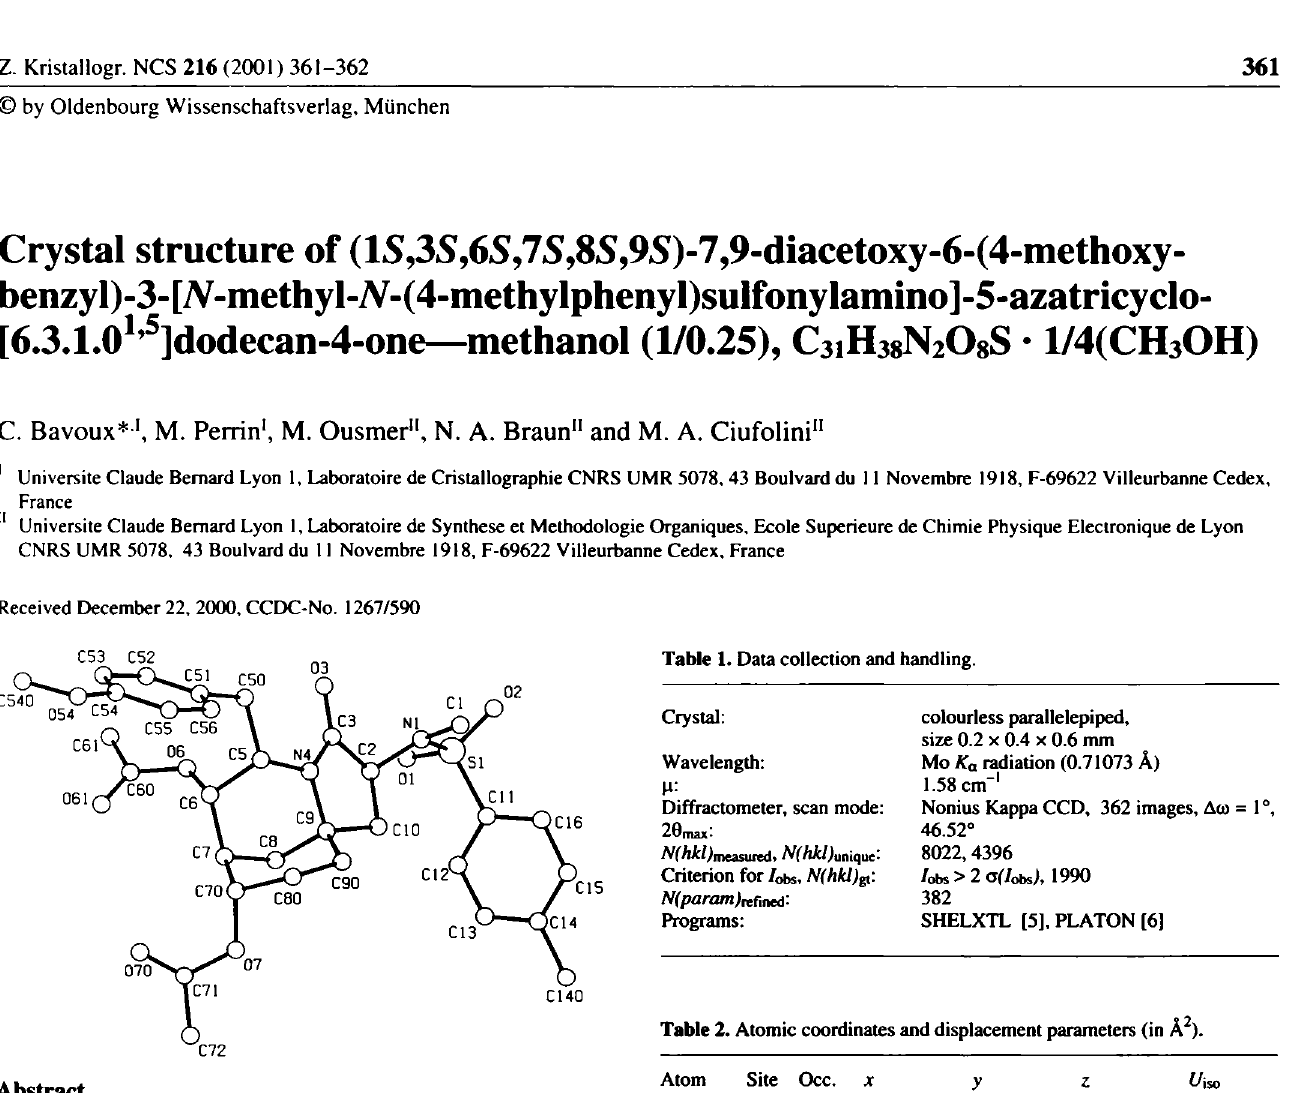
C31 .25H39N2O8.25S, tetragonal, />4ι2ι2(Νο. 92), a = 12.111(2)Ä, c = 42.151 (8) Ä, V = 6182.6 Ä 3 , Ζ = 8, R gl (F) = 0.075, wR a \i(F 2 ) = 0.182, 7"= 173 K.